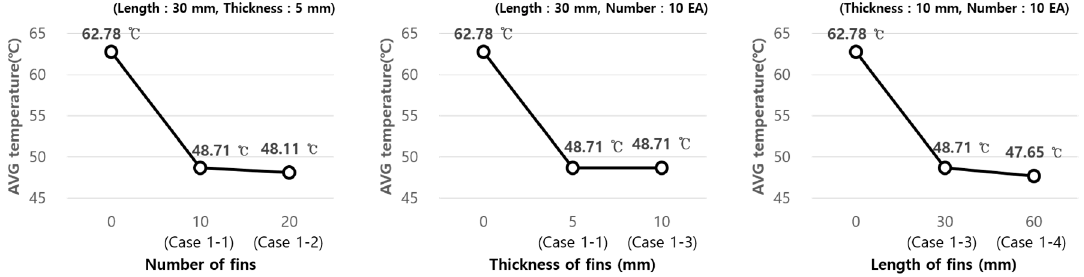
Figure 10. Variation of PV temperature as a function of